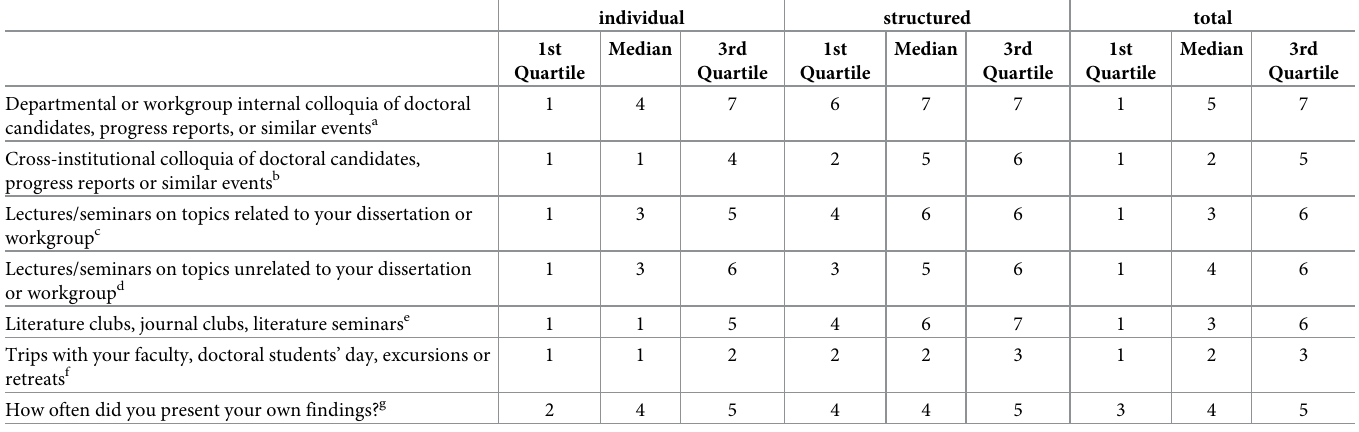
individual structured total 1st Median Quartile